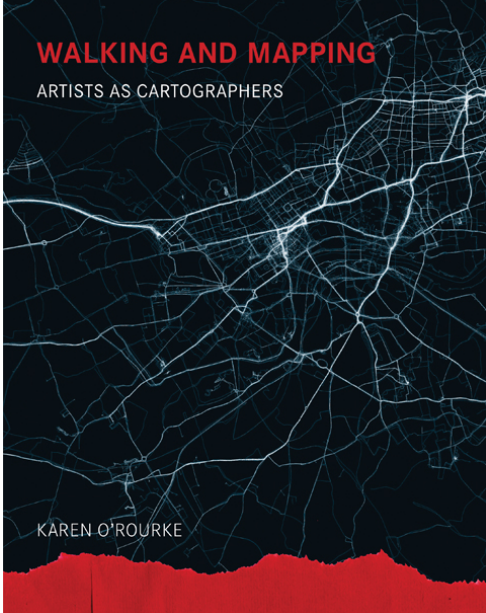
Figure 1. Walking and Mapping: Artists as Cartographers. Book